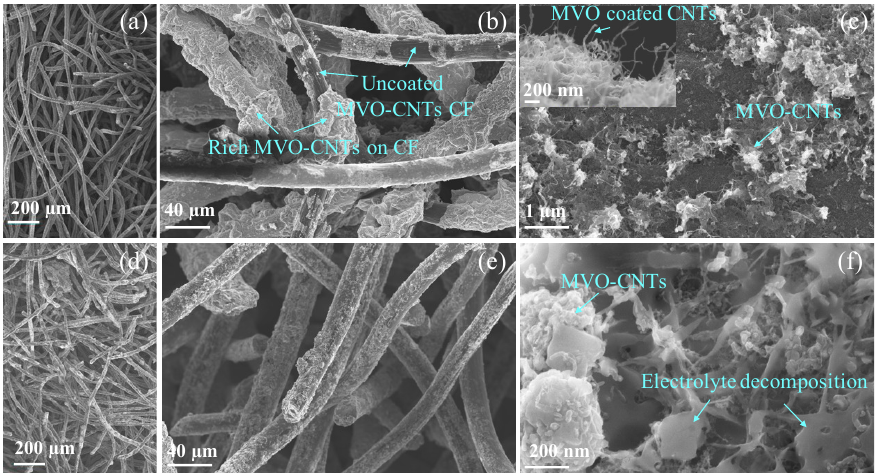
Figure 2. SEM images of pristine ( a – c ) and Na + cycled ( d – f ) MVO-CNTs electrodes, respectively, on the CF non-woven type network. The inset in ( c ) shows the high-resolution SEM image of MVO coated CNTs